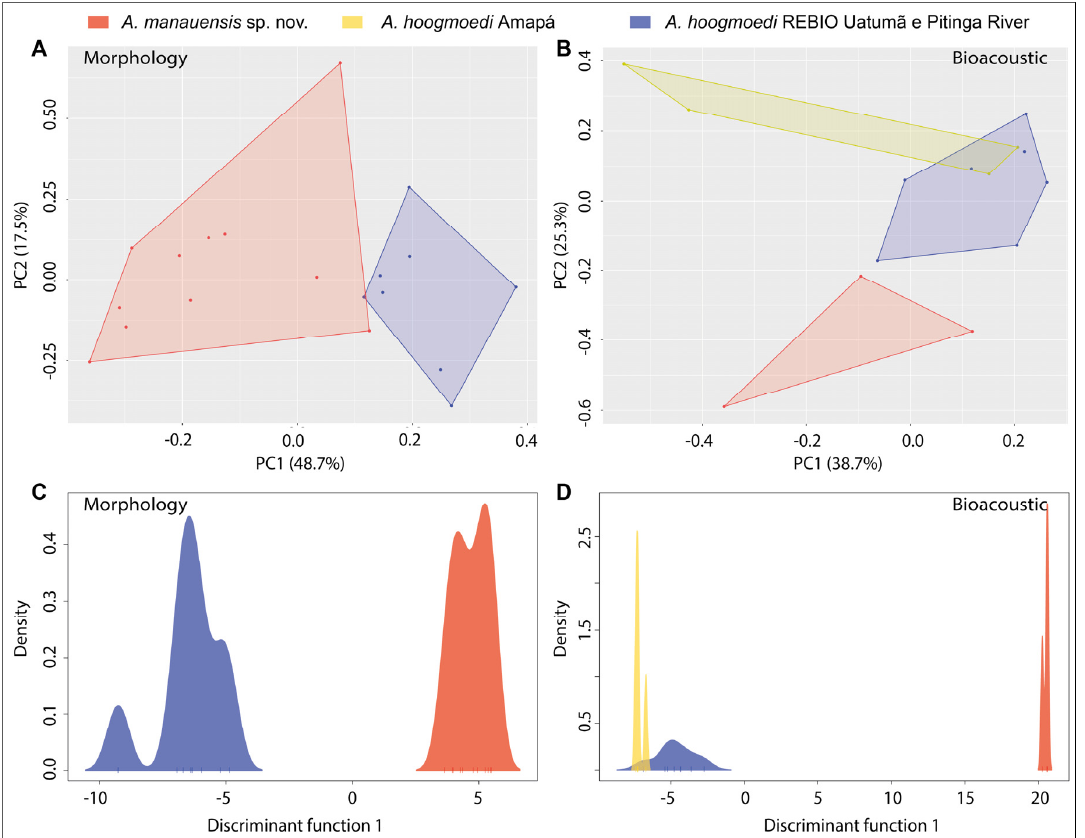
Figure 2. Principal Component Analysis (PCA) and Discriminant Analysis of Principal Components (DAPC) of Atelopus manauensis sp. nov. from Manaus (red) and Atelopus hoogmoedi from the state of Amapá (yellow) and REBIO Uatumã and Pitinga River (blue). All localities are in Brazil. ( A ) PCA for morphological variables (males); ( B ) PCA for advertisement call; ( C ) DAPC for morphological variables (males); and ( D ) DAPC for advertisement calls.